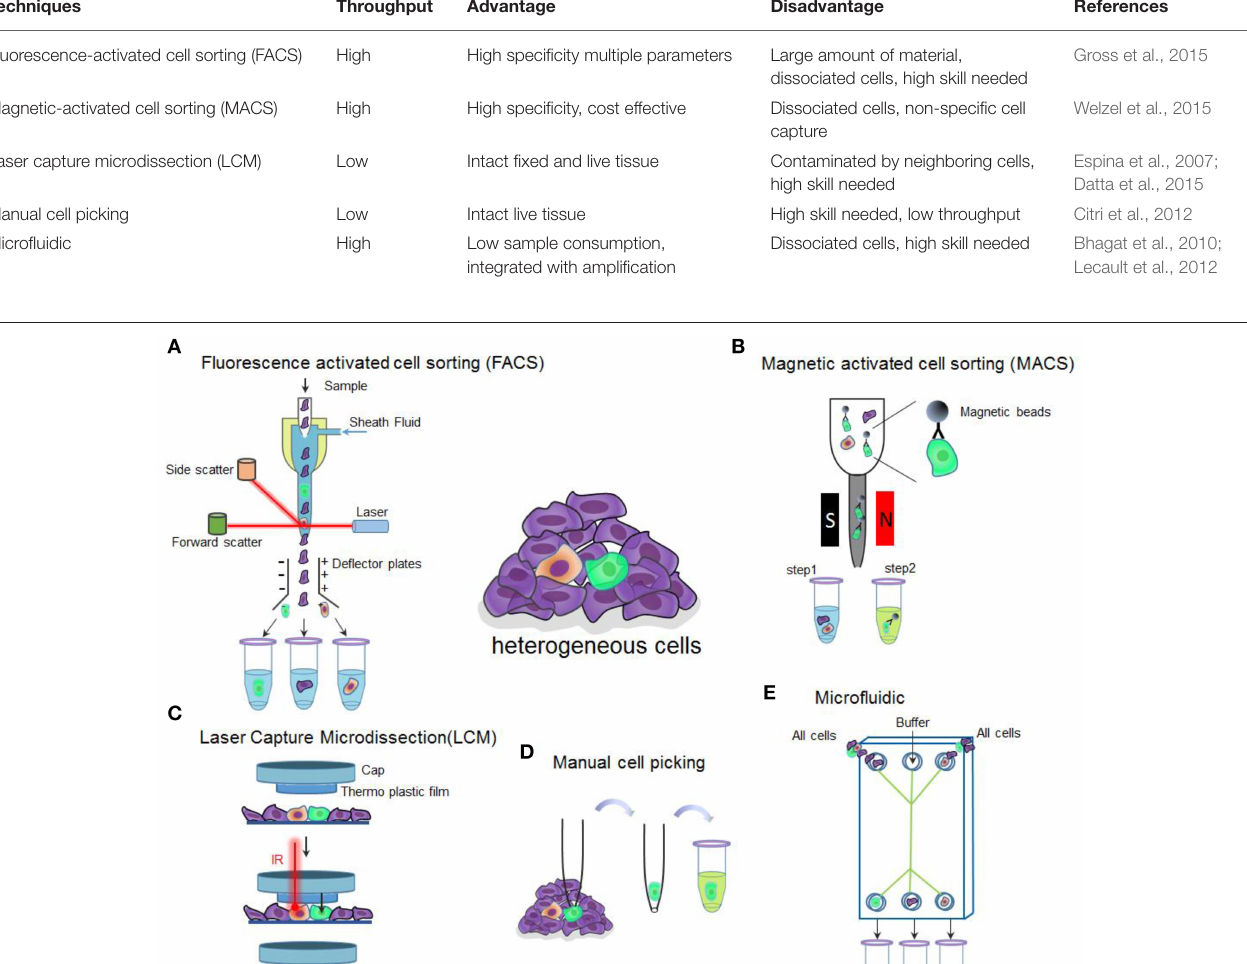
TABLE 1 | Overview of single cell isolation techniques.